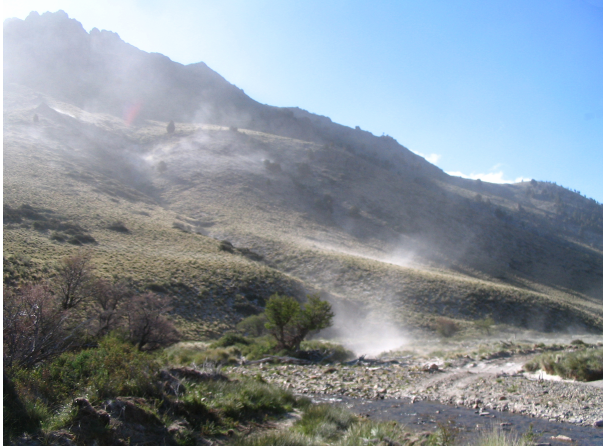
Figure 2. Ecotonal landscape in the affected area. Although known for commonly strong eolian conditions, this was a “calm” day with- out westerlies: this turbulence is due to daily thermal wind patterns, which shift ashes in any